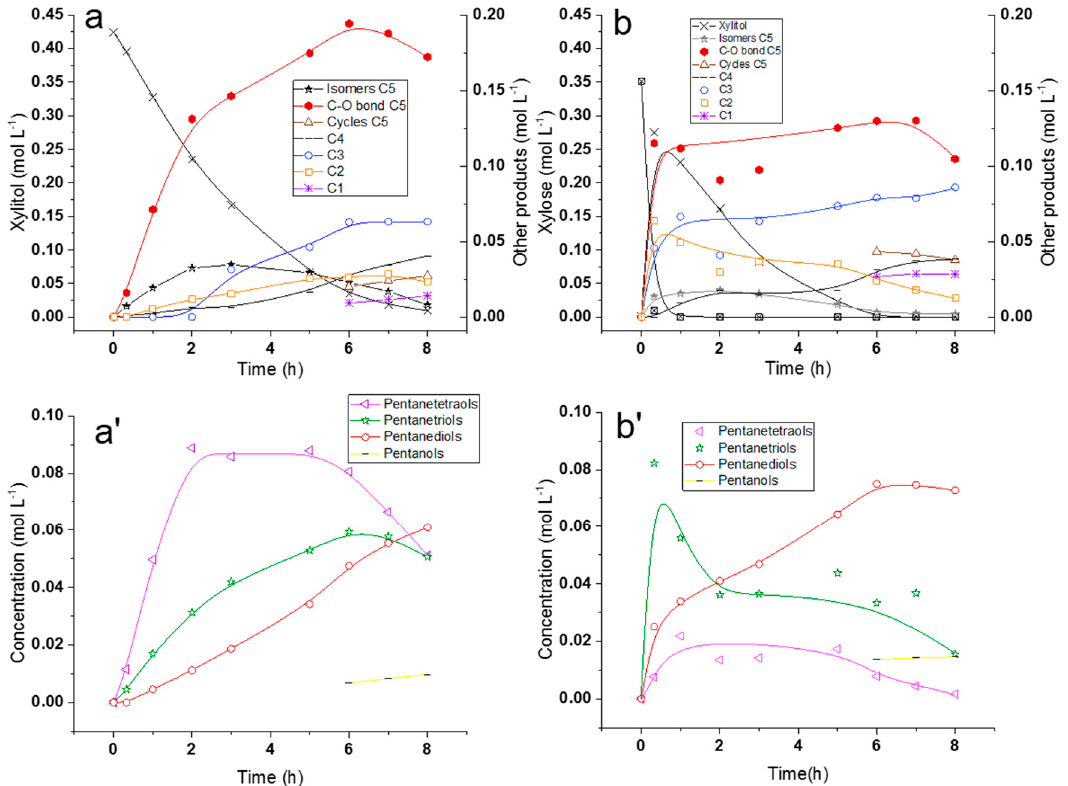
Figure 2. Evolution of ( a , b ) products families and ( a’ , b’ ) C-O bond C6 sub-families concentrations during hydrogenolysis of ( a , a’ ) xylitol (0.42 M), and ( b , b’ ) xylose (0.35 M), over ReO x -Rh/ZrO 2 catalysts (Re/Rh molar ratio = 1.5 for xylitol, 1.8 for xylose) at 200 °C under 80 bar H 2 , n xylitol /n Rh = 316, n xylose /n Rh = 264.